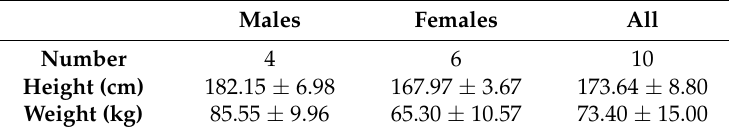
Table 1. Demographic details (mean ± SD) of the